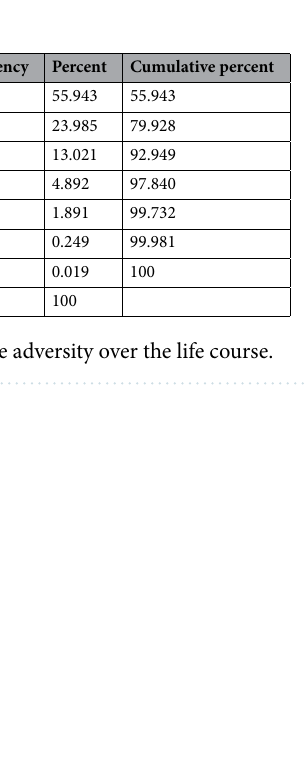
Table 2. Reliability for values of Ө from a graded response model fit for the Patient Health Questionnaire-9 questions (PHQ-9). TIF Test Information Function, SE Standard